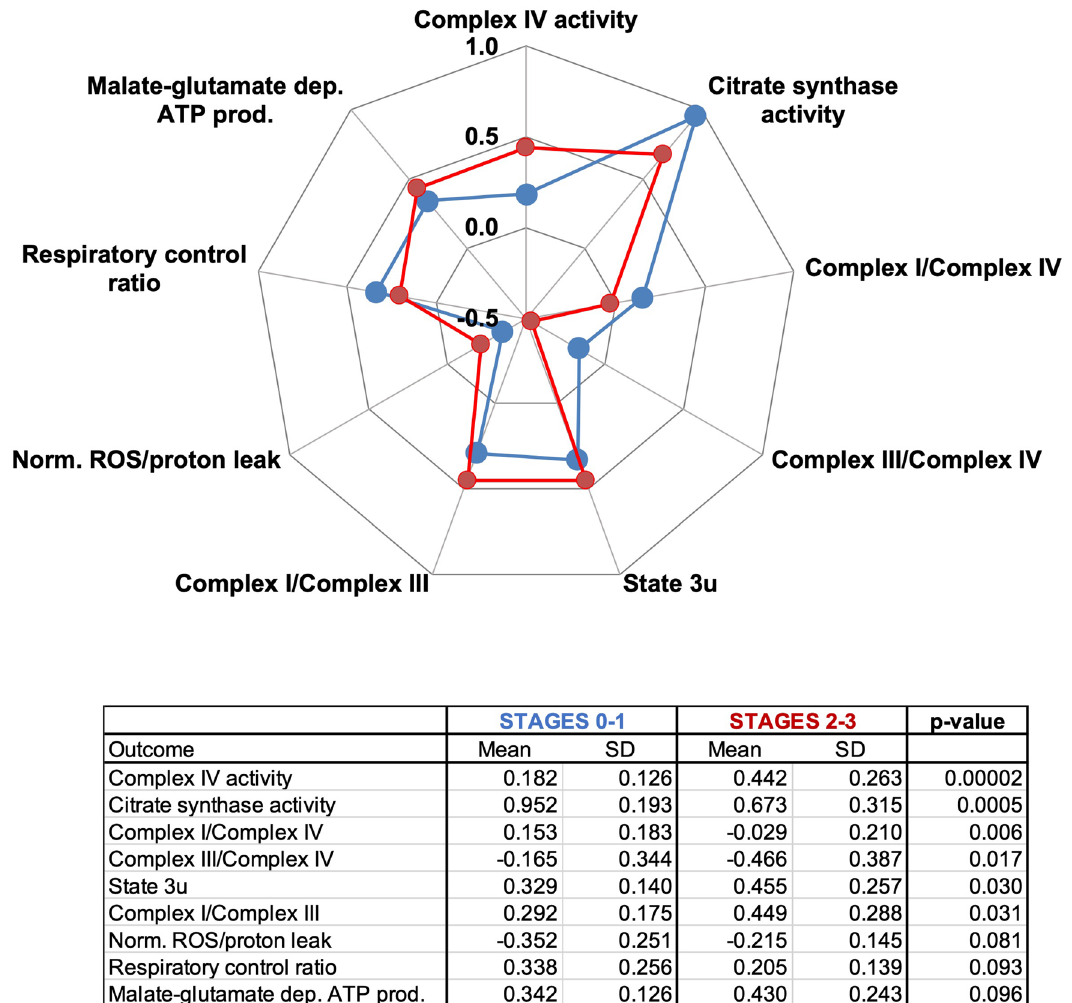
Figure 4. Bioenergetics of fibroblasts from patients at Stages 0–1 vs. 2–3. Top panel: Bioenergetic outcomes from primary fibroblasts obtained from carriers and assigned by the VRE algorithm as predicted Stages 0–1 (box A in Fig. 2C) or 2–3 (box B in Fig. 2C). The outcomes were plotted using a radar chart or spider web chart. For simplicity, only those with p ≤ 0.1 were shown—bottom panel: Statistical analyses performed using